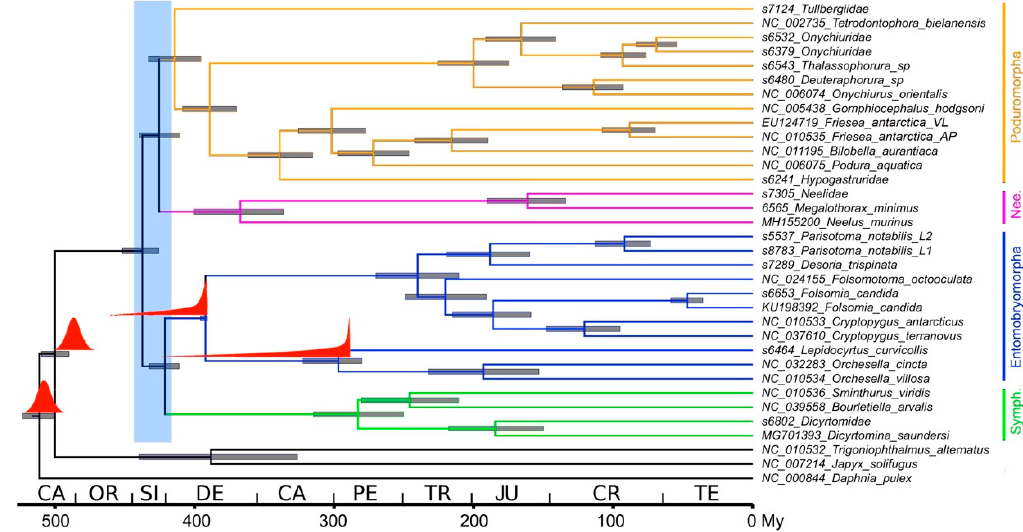
Figure 2. Dated tree based on first / second positions, see Table 2 (4th row) for complete prior information. Red insets indicate prior probability for node age, left to right: D. pulex vs. Hexapoda, Collembola vs. higher insects, R. praecursor , P. mirabilis . Blue inset indicates the time range corresponding to the diversification of collembolan orders.